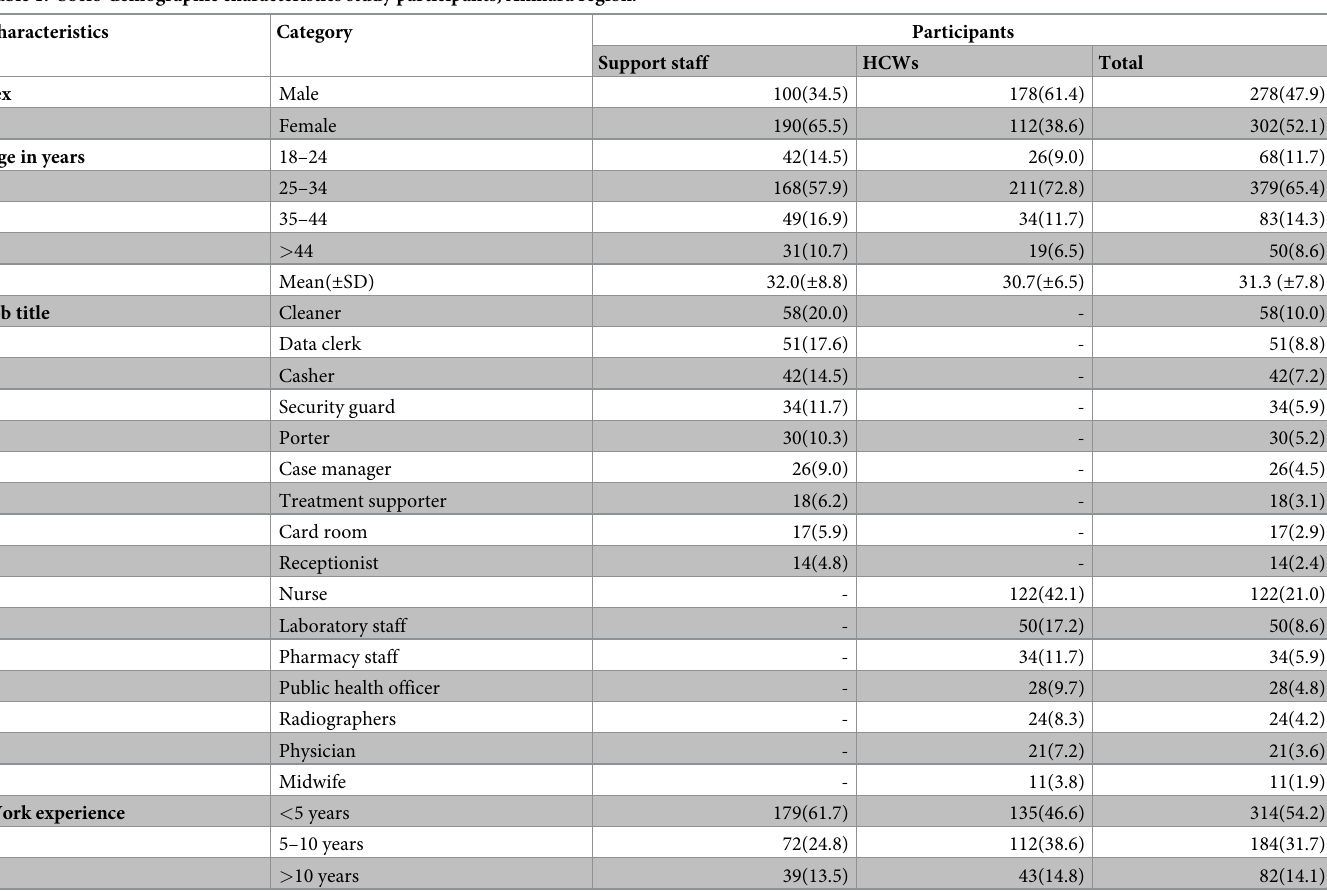
Table 1. Socio-demographic characteristics study participants, Amhara